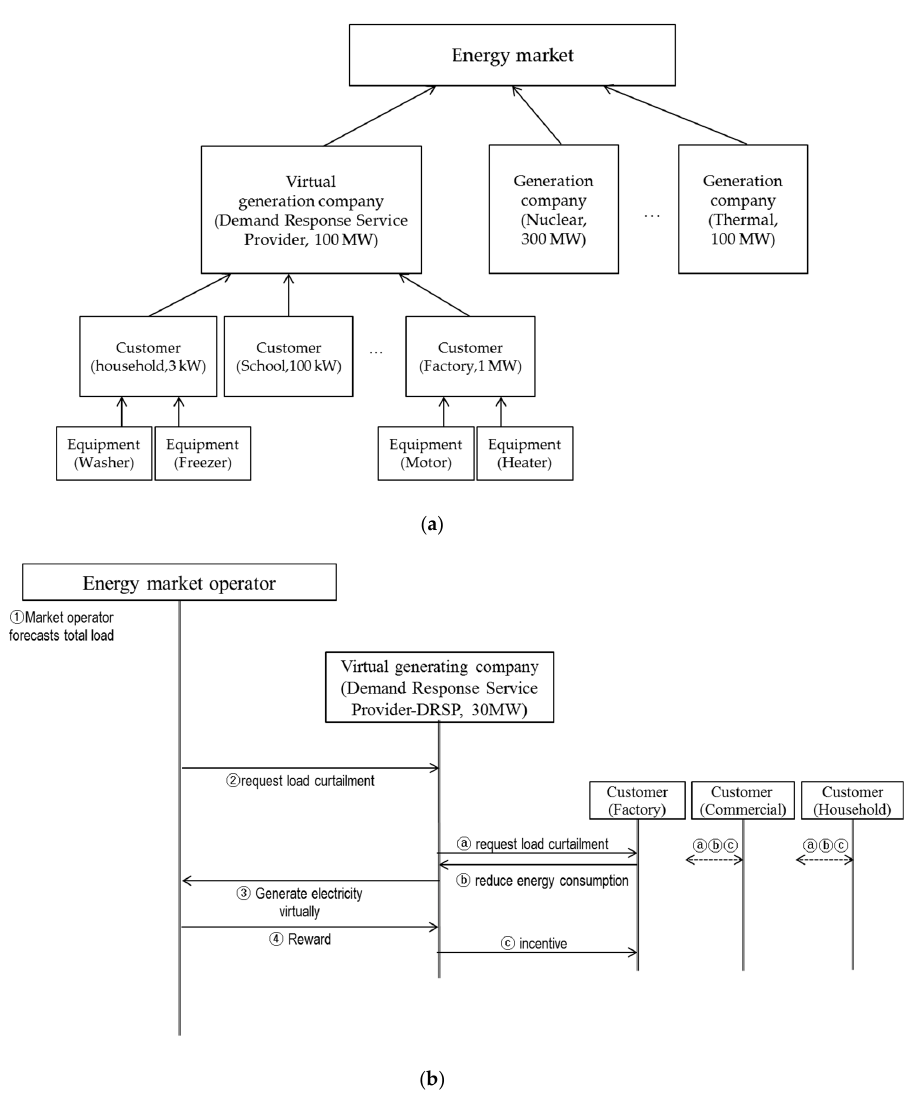
Figure 1. The structure of the considered demand response system. ( a ) Overall market structure; ( b ) detailed transaction procedure; Adapted with permission from [4], Jimyung Kang and Jee-Hyong Lee, Energies, MDPI, 2017. DRSP: demand response service provider.